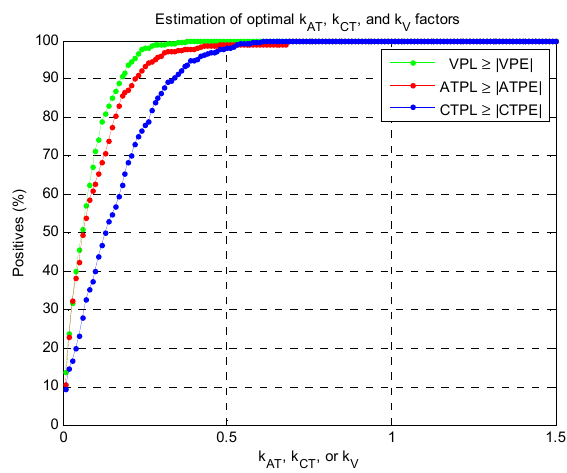
Figure 5. Search for optimal multiplicative factors for the LPL computations.